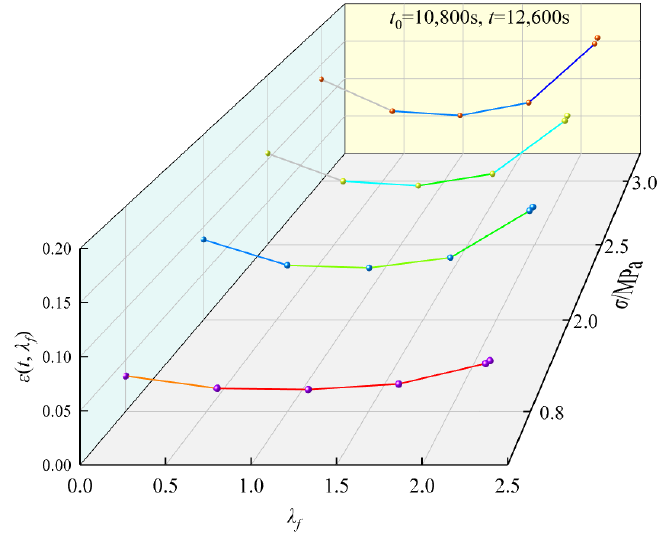
Figure 6. Relationship between creep strain and f.